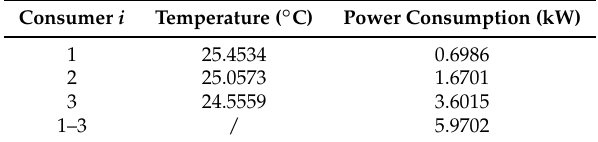
Figure 10. The convergence of the retail price. Table 4. The temperature settings and energy consumption in IEEE 9-bus system.